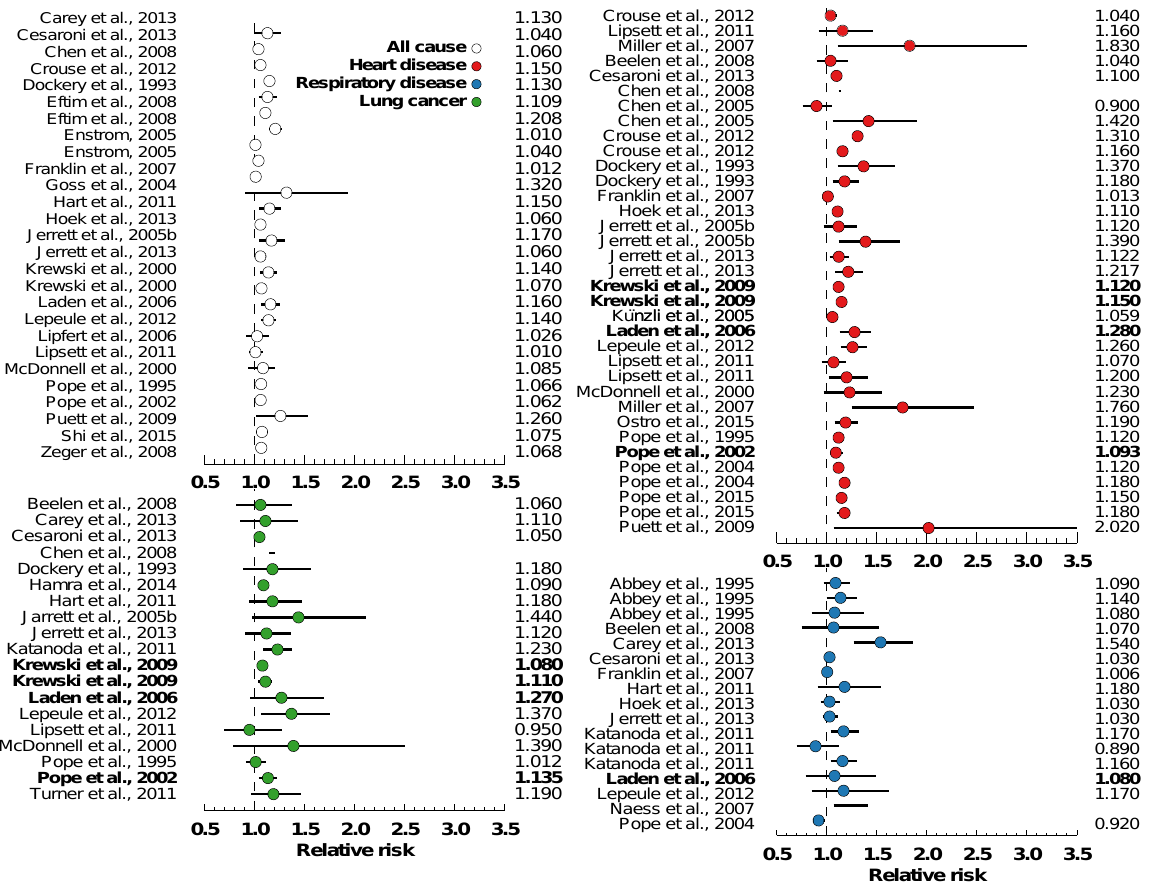
Figure 2. Relative risk ratios from select previous studies for mortality due to chronic exposure to PM 2 . 5 (given as per 10µgm − 3 increase) colored by cause of death. Studies applied in this work are highlighted in